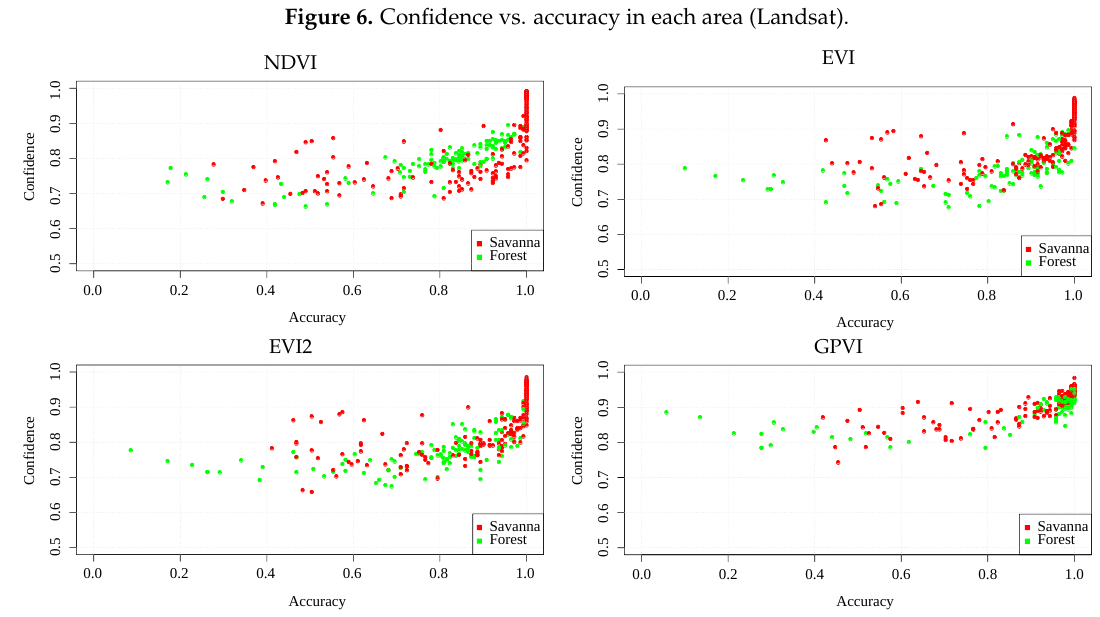
Figure 7. Confidence vs. accuracy in each area